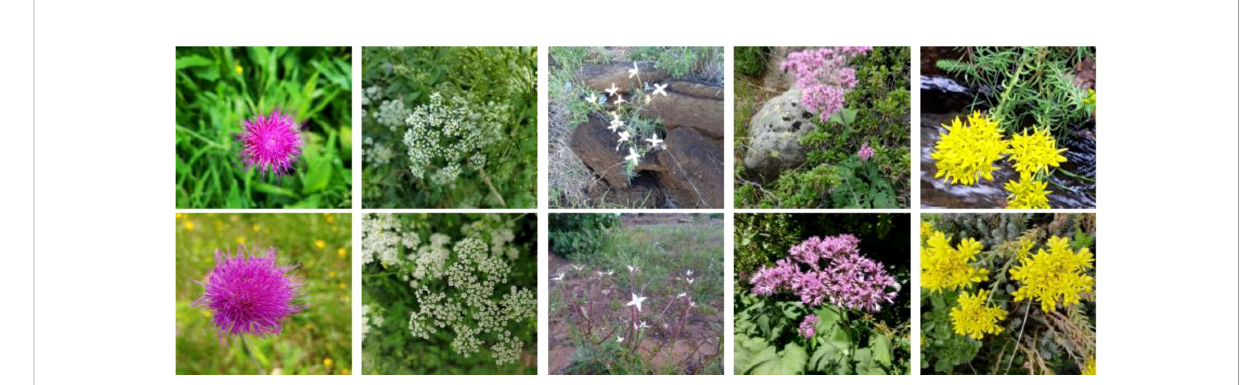
FIGURE 6 Examples of visually similar images belonging to two different classes.